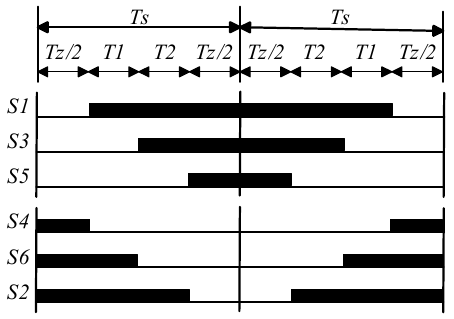
Figure 6. Gating sequence for the switches.